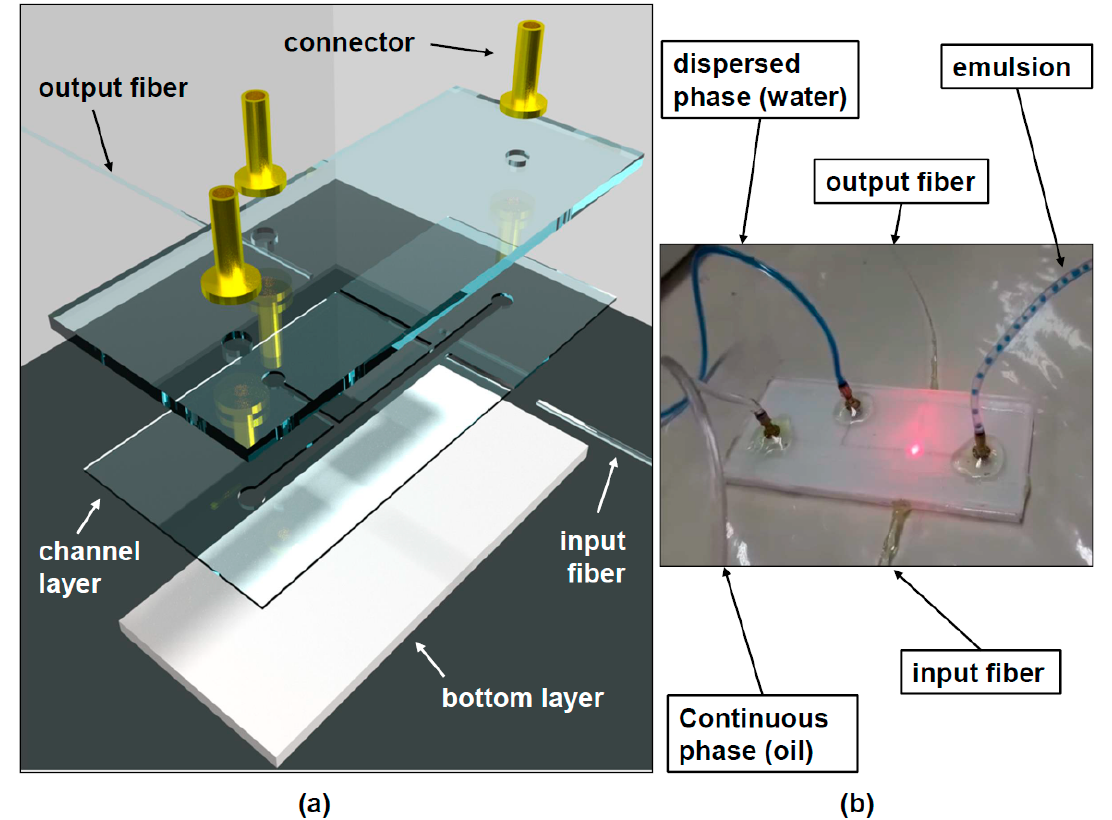
Figure 1. ( a ) Illustration of the fabricated device and ( b ) actual device generating emulsion (blue dye was added to the water phase, just for this picture, in order for the droplets to be visible).